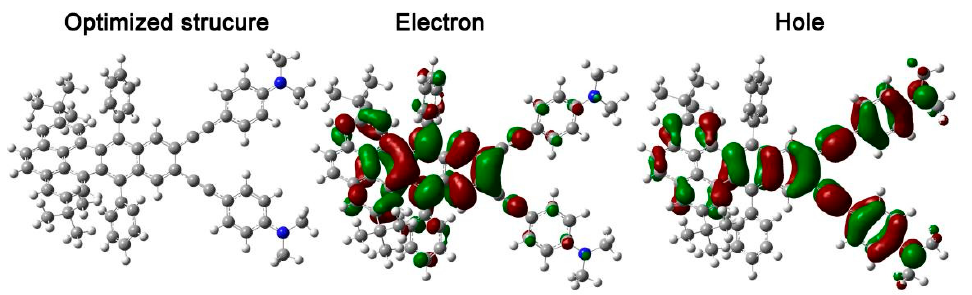
Figure 1. Optimized structure and the natural transition orbitals in the first excited state (S1) of PyDN .